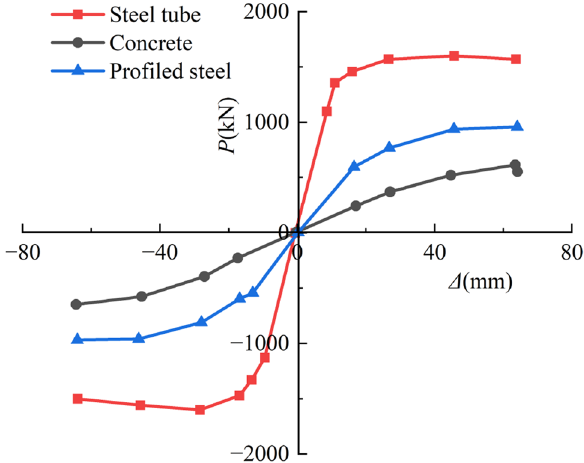
Figure 20. Skeleton curves of P- Δ relations.